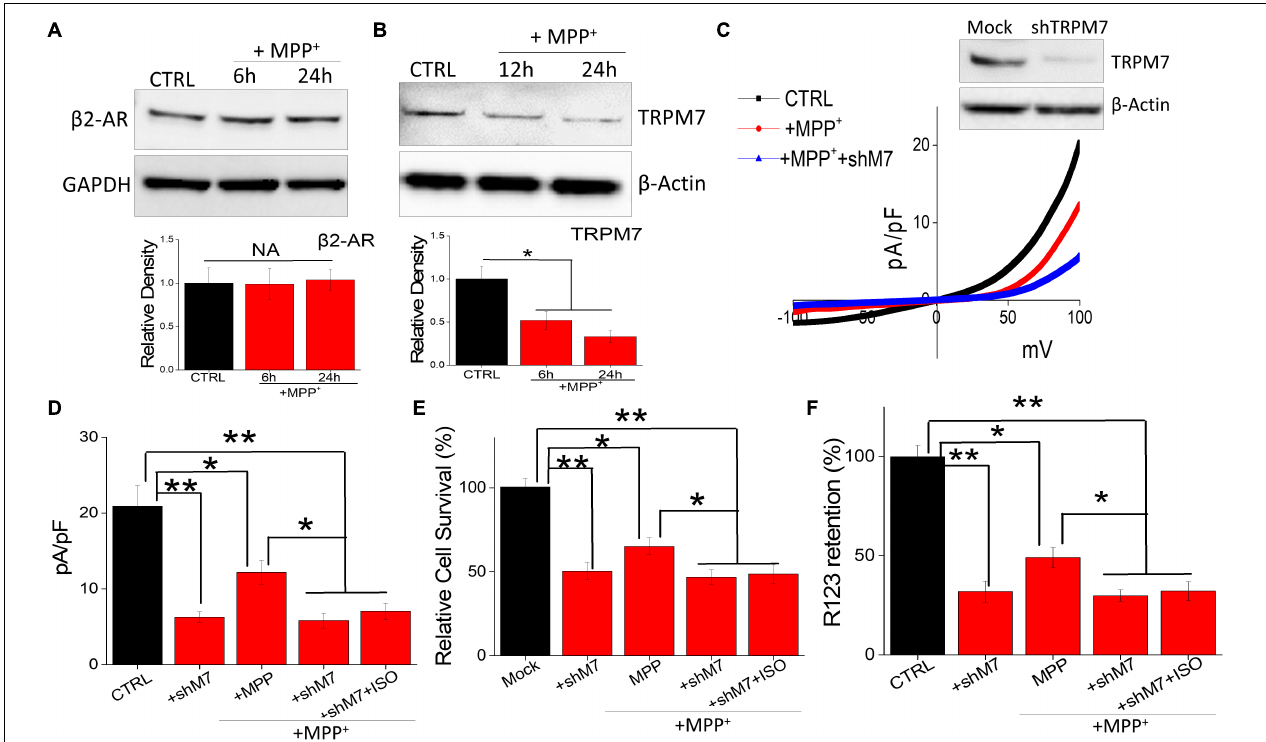
FIGURE 4 | Neurotoxin treatment inhibits TRPM7 expression/function: (A) Western blots showing the expression of β 2 -adrenergic receptor (A) , TRPM7 (B) . β -actin was used as a loading control in CTRL and MPP + -treated (500 µ M for 24 h) cells. (C) IV curve and quantitation of currents observed are shown from control, MPP + treatment (500 µ M, 24 h), and shTRPM7 cells. (D) The columns represent means ± SD of 6 independent experiments. (** p < 0.01, * p < 0.05; was established using one-way ANOVA, Tukey post hoc test). MTT assays (E) and mitochondrial transmembrane potential (F) were evaluated under various conditions as labeled in the figure. The concentration of ISO used was 20 µ M and for MPP + 500 µ M was used for each experiment. The columns show the means ± SEM of 4 independent experiments. (** p < 0.01, * p < 0.05).